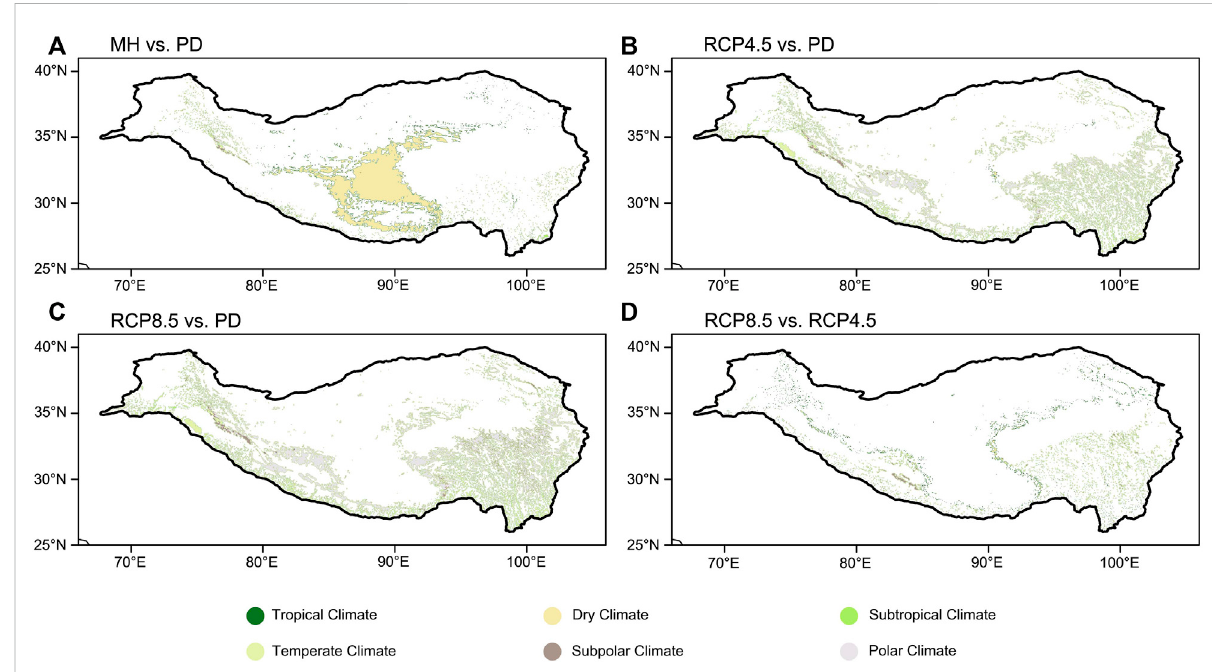
FIGURE 9 Distribution of the difference in major climate types (detailed information in Table 1) across the selected warming periods. (A) MH vs. PD, (B) RCP4.5 vs. PD, (C) RCP8.5 vs. PD, (D) RCP8.5 vs. RCP4.5. Except for white, the colors in the four maps represent the climate types of PD. The white paint inside TP indicates that the major climate types did not change between the two